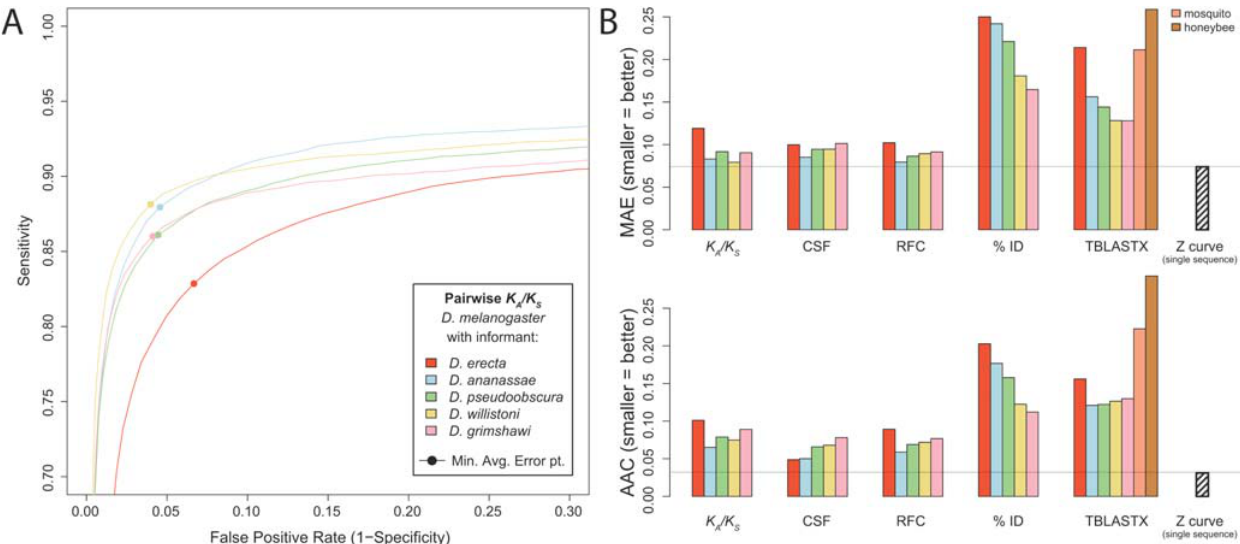
Figure 4. Pairwise discovery power using different informant species. (A) ROC curves for K A / K S using D. melanogaster with each of five different informant species. Species at a wide range of evolutionary distances performed comparably, except for D. erecta , the most closely related to D. melanogaster , which clearly underperformed the others. (B) MAE and AAC error statistics for each pairwise comparative metrics applied to the same five informants. D. ananassae (blue) is overall the preferred informant, but not uniformly so. For TBLASTX, the performance is also shown using mosquito ( Anopheles gambiae ) and honeybee ( Apis mellifera ), which led to worse performance than the Drosophila species. No pairwise comparison outperformed the best single-sequence metric (Z curve).